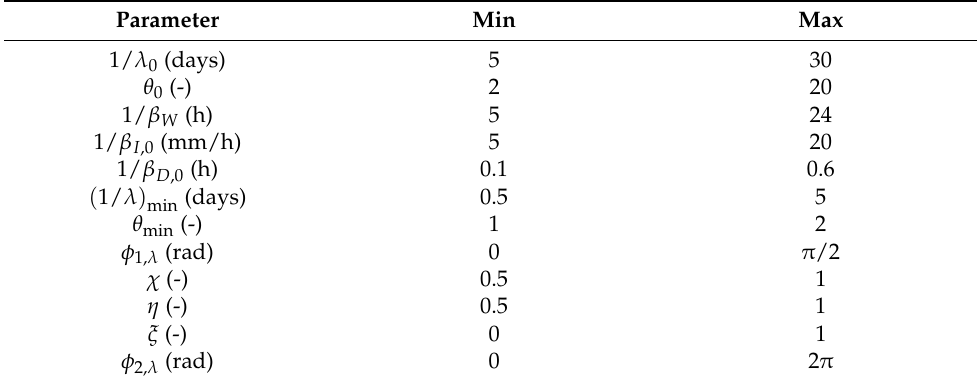
Table 1. Ranges of variation for parameters in STORAGE, according to [7,54].